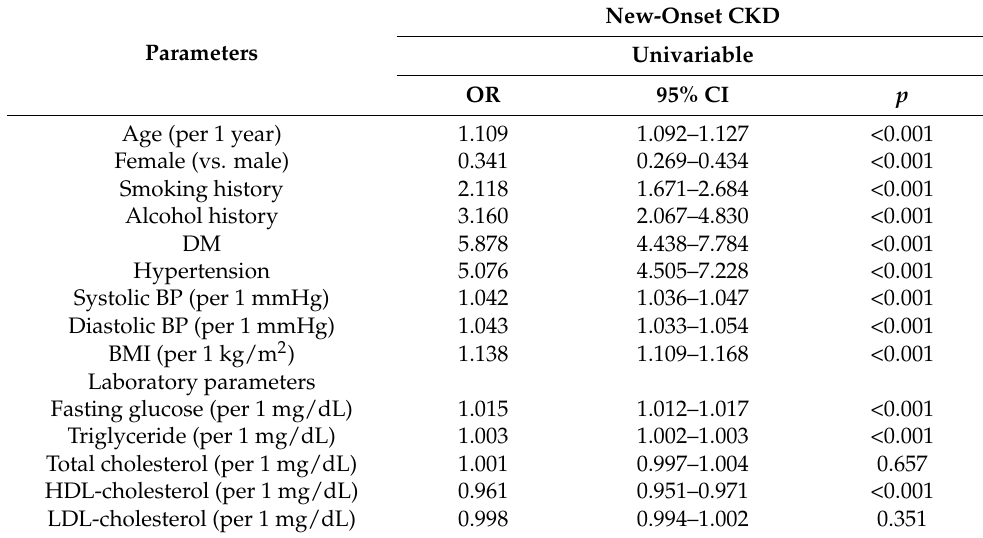
Table 2. Determinants for new-onset CKD using univariable logistic regression analysis.